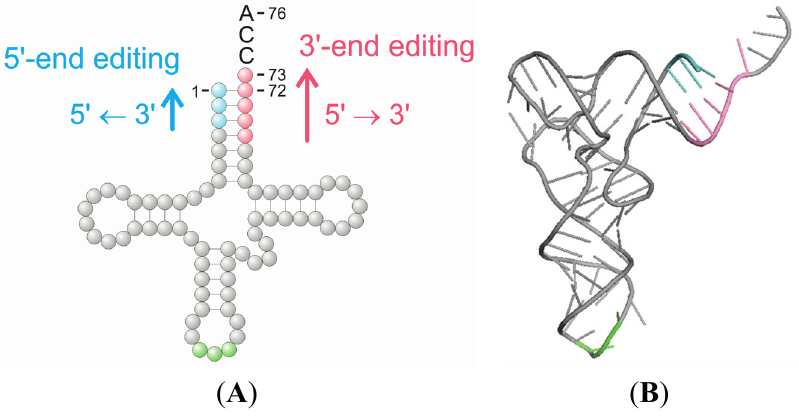
the poly(A) polymerase, the CCA-adding enzyme, or the TRAMP complex (TRAMP: Trf4 or Trf5/Air2/Mtr4 polyadenylation; Trf: topoisomerase I-related function, poly(A) polymerase activity; Air: arginine methyltransferase-interacting RING finger, RNA binding protein; Mtr4: mRNA